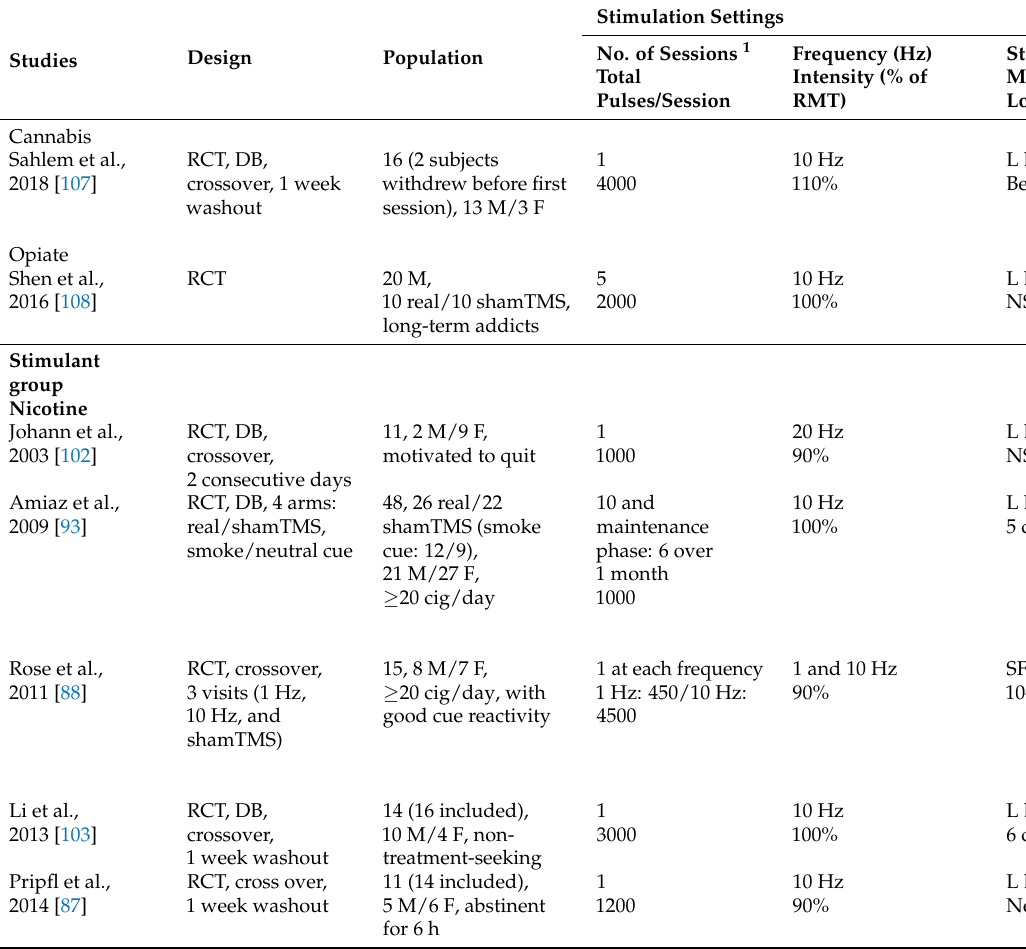
QSU-B (cue-induced, neutral/smoke) *